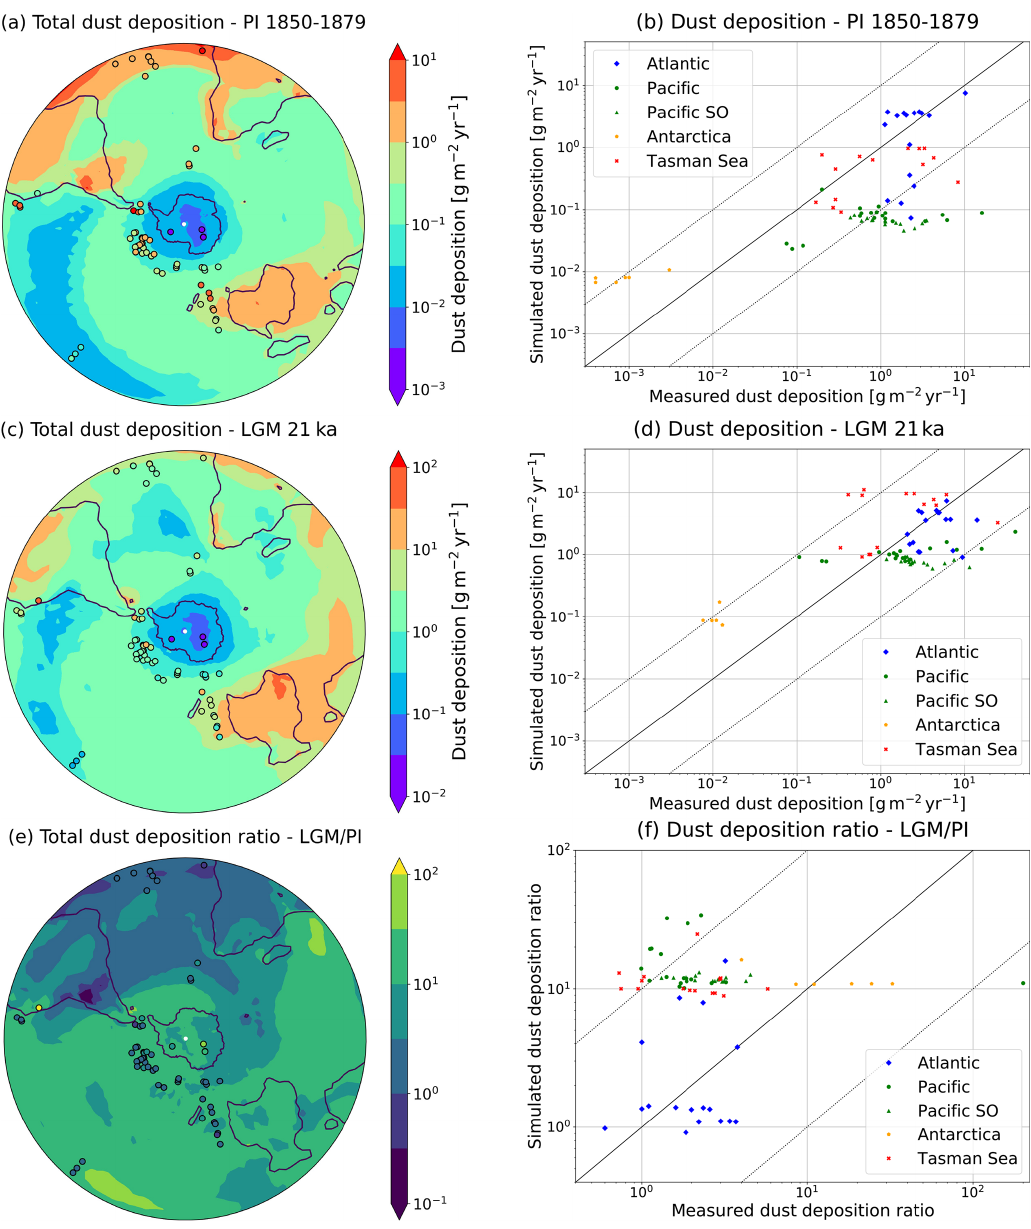
Figure 3. Comparisons between the simulated total dust deposition and observational data (Kohfeld et al., 2013) (in gm − 2 yr − 1 ) from several regions in the Southern Hemisphere and the according scatter plots for the PI (a, b) and LGM (c, d) . Panels (e) and (f) show the according simulated and measured dust deposition ratio LGM/PI. Please note the different value ranges in (a) and (c)